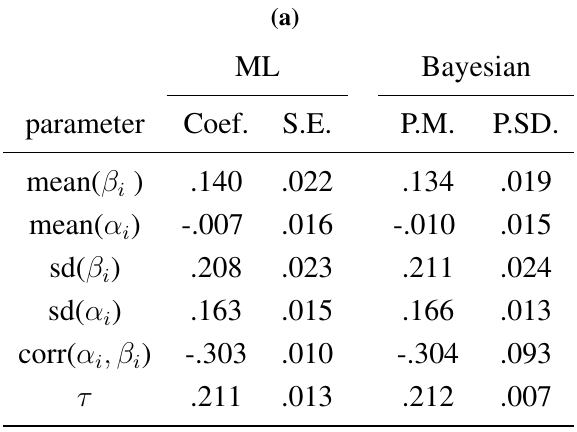
Table 1. (a) Hierarchical Maximum Likelihood (ML) and hierarchical Bayesian estimates and their standard errors for the means and standard deviations of the other-regarding preference parameters ( α, β ) and the standard deviation of the evaluation error ( τ ). (b) Bivariate scatter plot of empirical Bayes estimates of ( α, β )